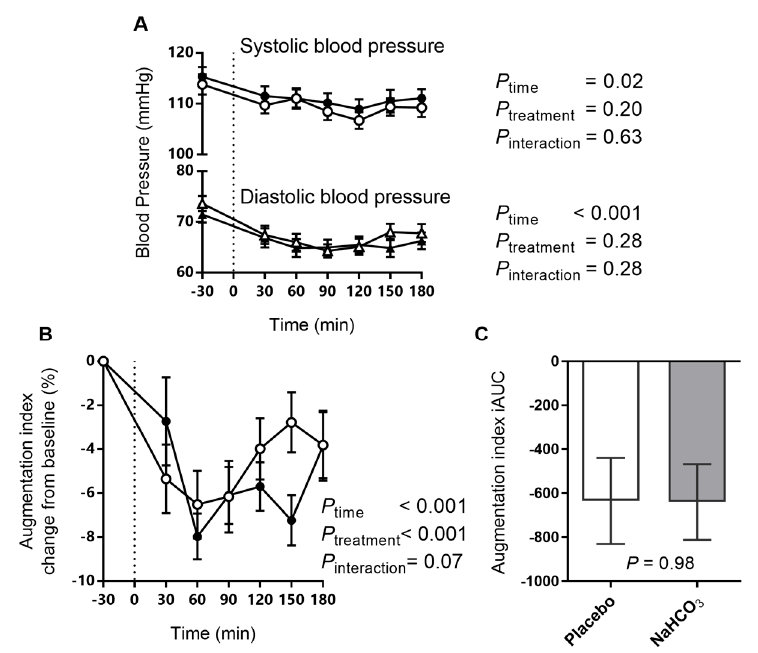
Figure 6. The effect of oral NaHCO 3 (1680 mg) administered prior to a high acid load meal on systolic and diastolic blood pressure ( A ); the augmentation index ( B ) and the augmentation index iAUC ( C ), comparing NaHCO 3 (solid symbol) and placebo (hollow symbol). Treatment was administered at t = − 30 min and the meal was completed at t = 0 (indicated by a dotted line). The effect of the treatment versus placebo on the postprandial outcome measure was tested by two-way repeated measure ANOVA and the difference in iAUC was tested by paired t -test, with p values indicated on the graphs. All data presented as mean ± SEM.